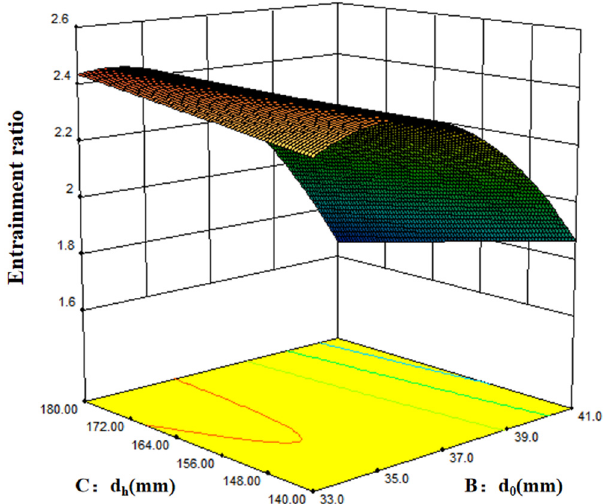
Figure 4. Response surface diagram of the influence of B and C on the entrainment ratio.